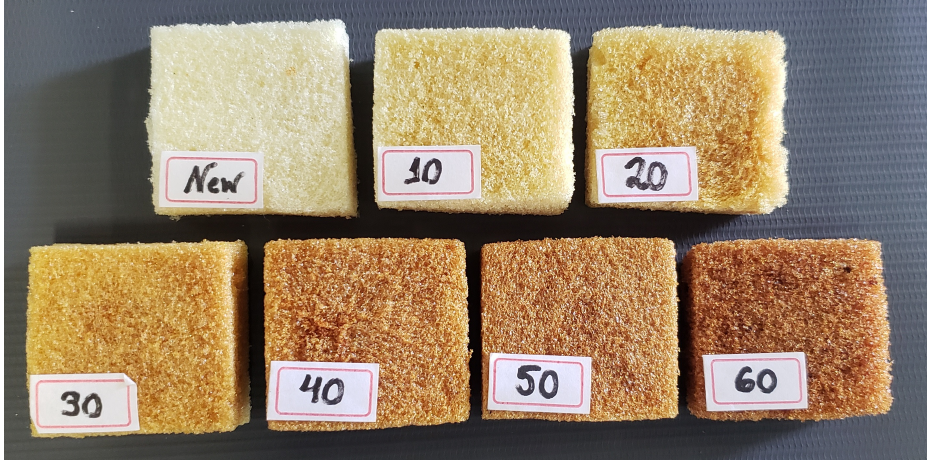
Figure 6. Difference in the PUF color after the ageing process.